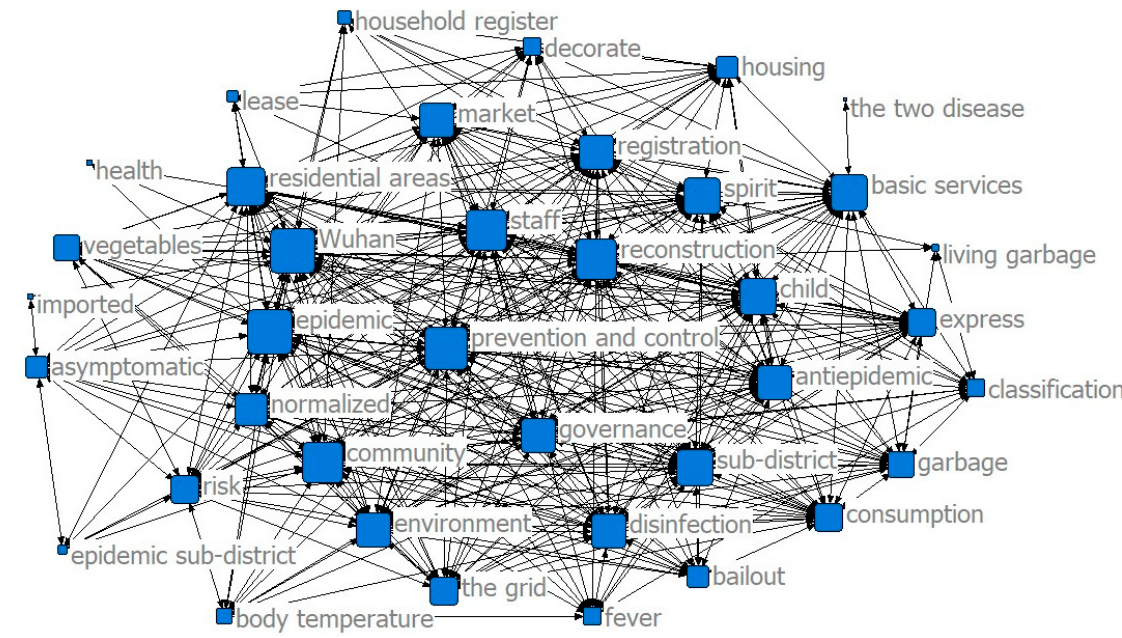
Figure 4. Community service content in the normal period.